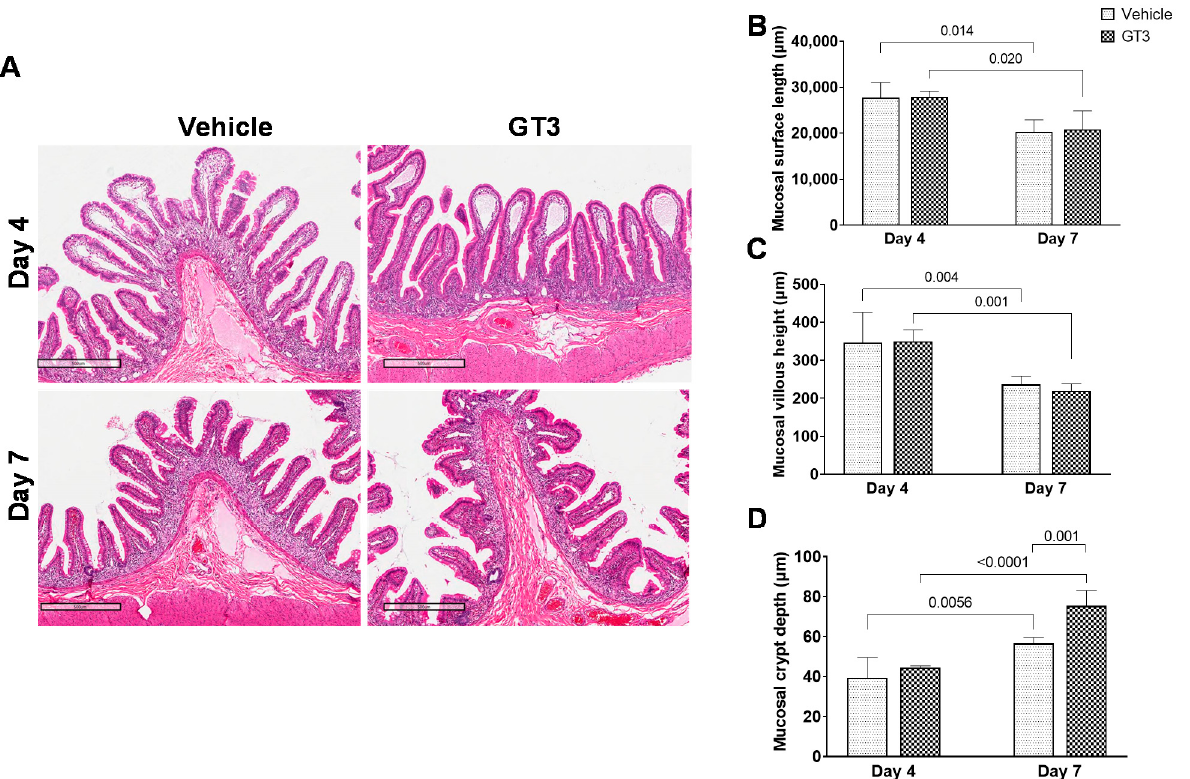
Figure 1. Effects of GT3 on irradiation-induced intestinal damage at day 4 and day 7. ( A ) Representative images showing the cross sections of proximal jejunum treated with vehicle or GT3 at day 4 and 7 post-irradiation. Histogram showing the measurements of intestinal injury such as ( B ) mucosal surface length, ( C ) villous height, and ( D ) crypt depth. The data are presented as average ± SEM; N = 3 (day 4) and N = 5 (day 7).